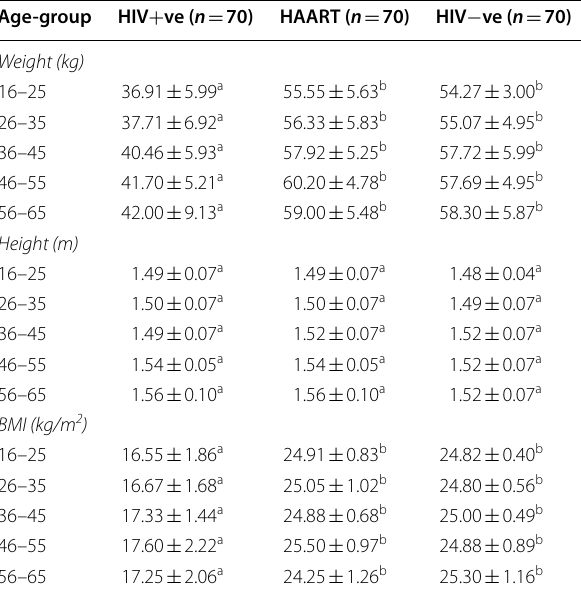
Table 3 Anthropometric indices of HIV-positive patients, HIV-positive patients on antiretroviral drugs and HIV-negative subjects